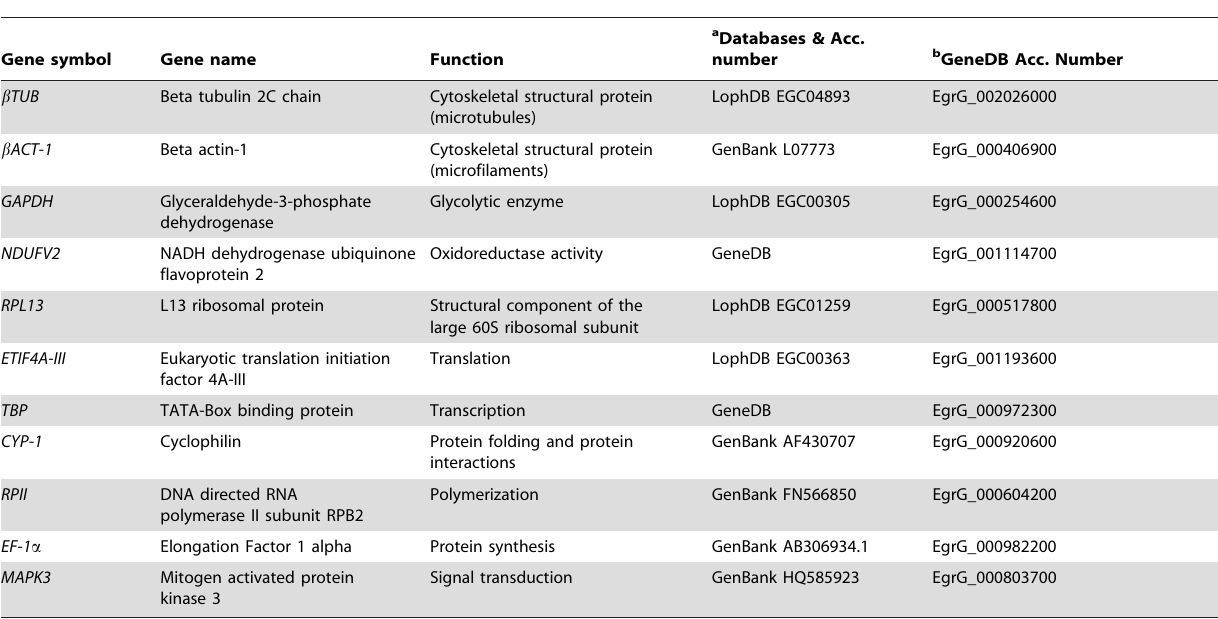
Table 1. Descriptions of candidate reference